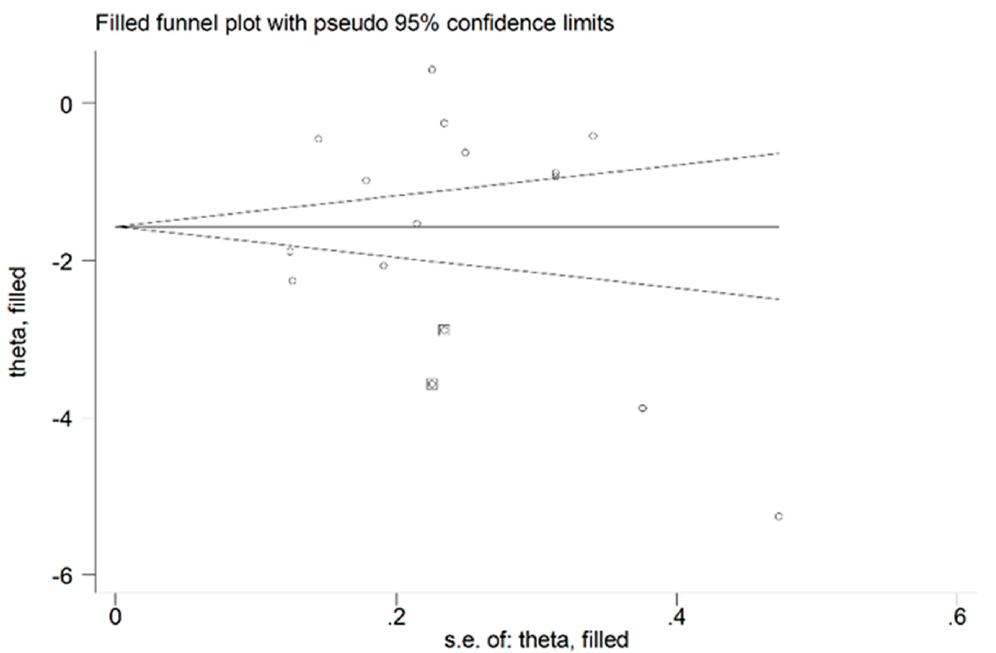
Figure 5. Funnel plot of studies investigating the association between blood/erythrocytes GPx concentration and COPD disease after trimming and filling. Dummy studies and genuine studies are represented by enclosed circles and free circles, respectively.